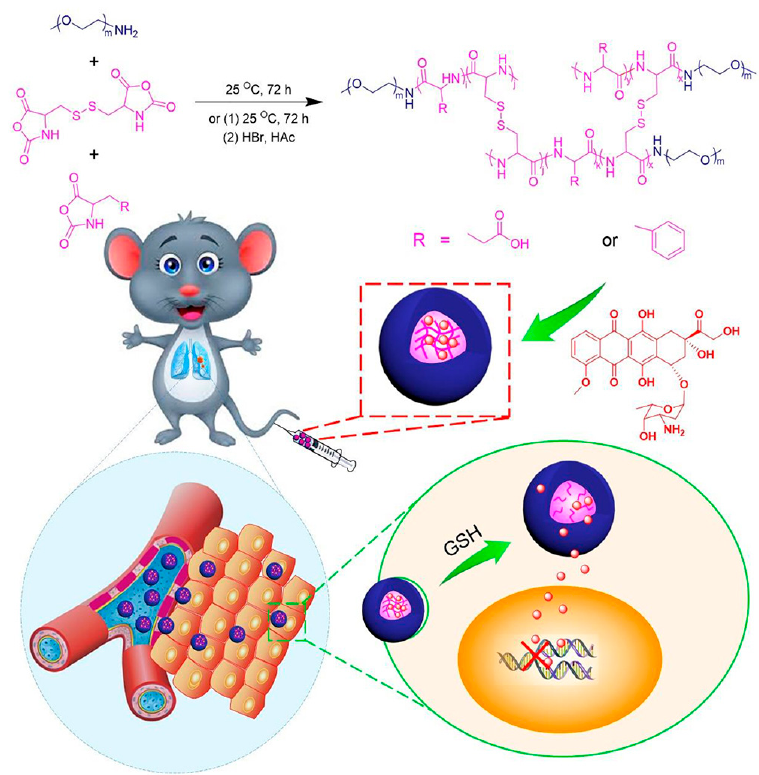
Figure 7. (Top) Synthesis pathways of the reduction-responsive methoxy poly(ethylene glycol)– poly(L-phenylalanine- co -L-cystine), (mPEG–P(LP-co-LC))- and methoxy poly(ethylene glycol)– poly(L-glutamic acid-co-L-cystine), (mPEG–P(LG-co-LC)) NGs. (Center) DOX encapsulation to hybrid NGs. (Bottom) DOX-hybrid anogels circulation, intratumoral accumulation, endocytosis, and targeting release after intravenous injection. Reprinted from Reference [117].